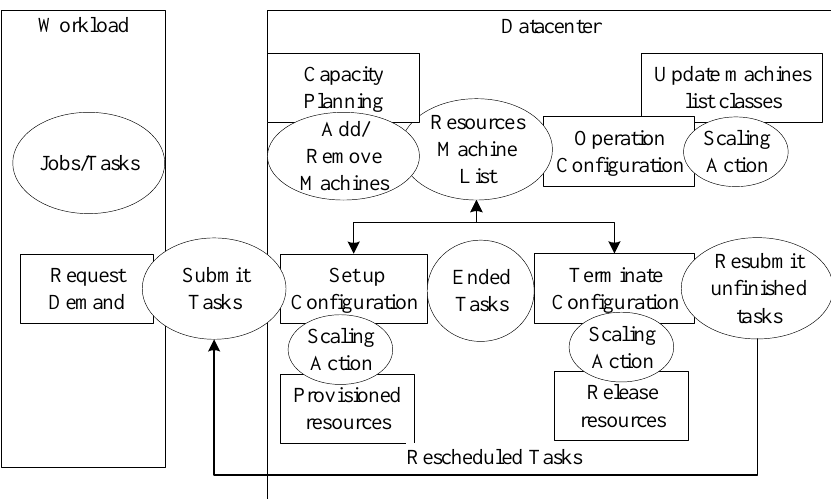
Figure 7. Architecture of the data center and workload